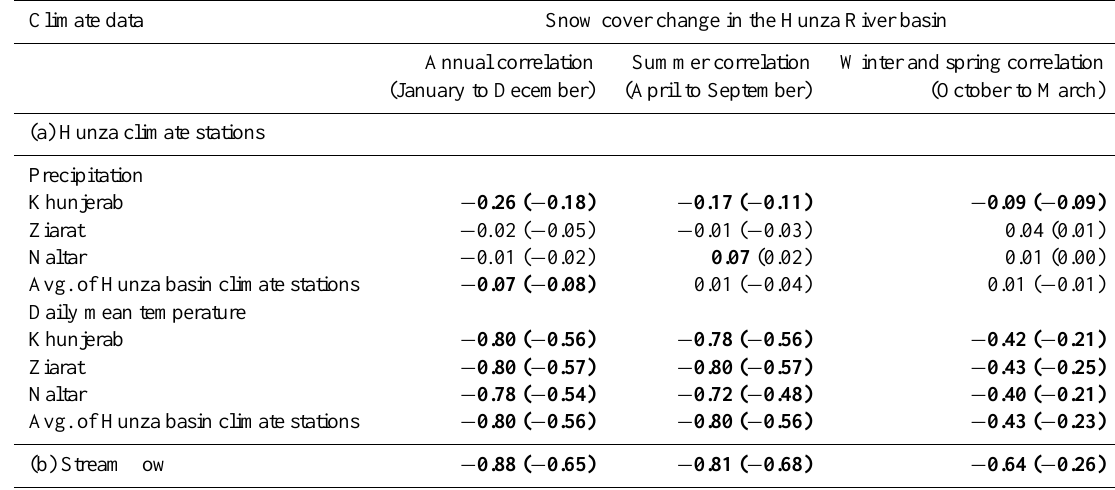
Table 6. Annual and seasonal correlation coefficients between snow cover change, Hunza River basin (2000–2008), and a) daily climate data (precipitation and temperature) (2000–2008), b) daily stream flow data at Dainyor bridge (2000–2008).